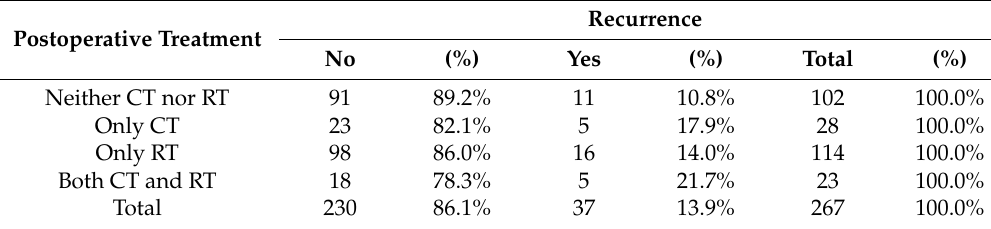
Table 3. Postoperative treatments and the recurrence rate.